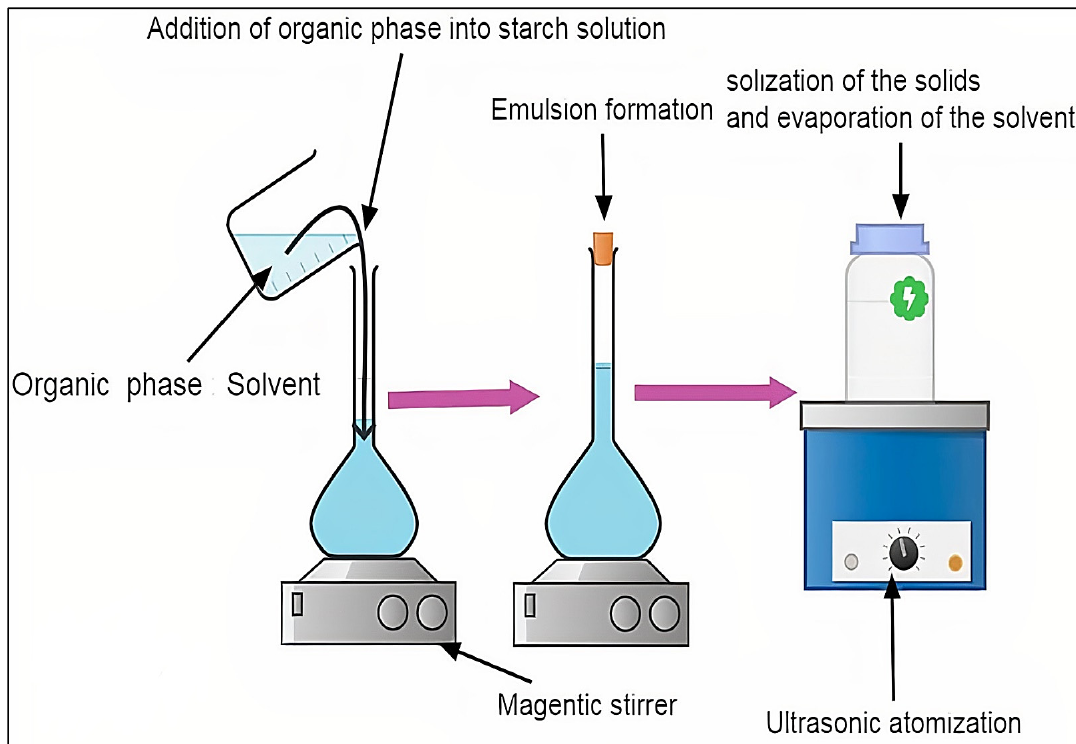
Figure 5. Ultrasonication with/without acid hydrolysis.